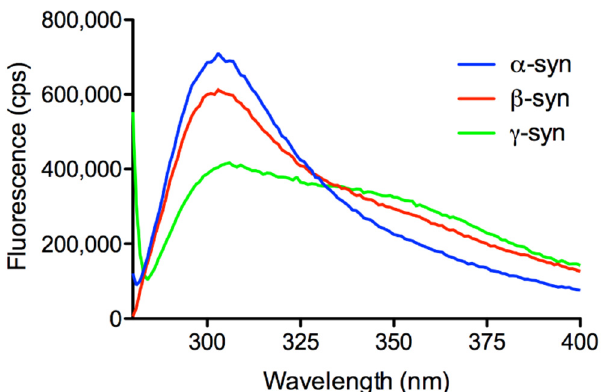
Figure 6. Fluorescence spectra of purified recombinant Xenopus syns. Protein concentration was 0.11 mg/mL for α - and β -syn, and 0.24 mg/mL for γ -syn.